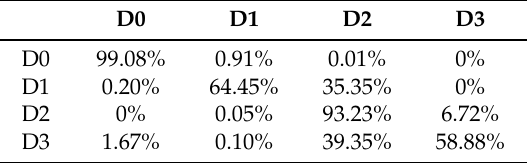
Table 6. PLS predictions for the propranolol set. Confusion matrix for dosages of propranolol prediction. D0